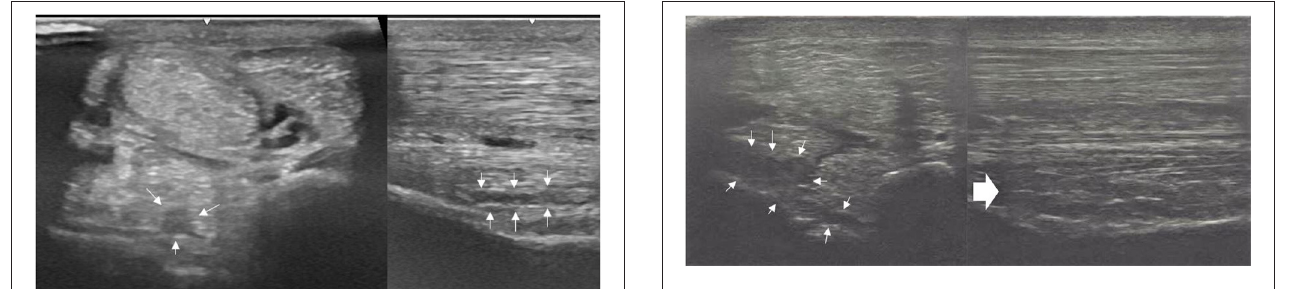
FIGURE 1 | A transverse image of a proximal suspensory ligament grade 1 lesion about 4cm distal to the head of the MTII. The lesion appears as a focal, well-defined, hypoechogenic area (white arrows) in the ligament occupying < 25% of the cross-sectional areal. Longitudinally the lesion is well-demarcated (white arrows), it begins from the insertion and extends distally. In transverse image medial is to the left; in longitudinal image proximal is to the left.